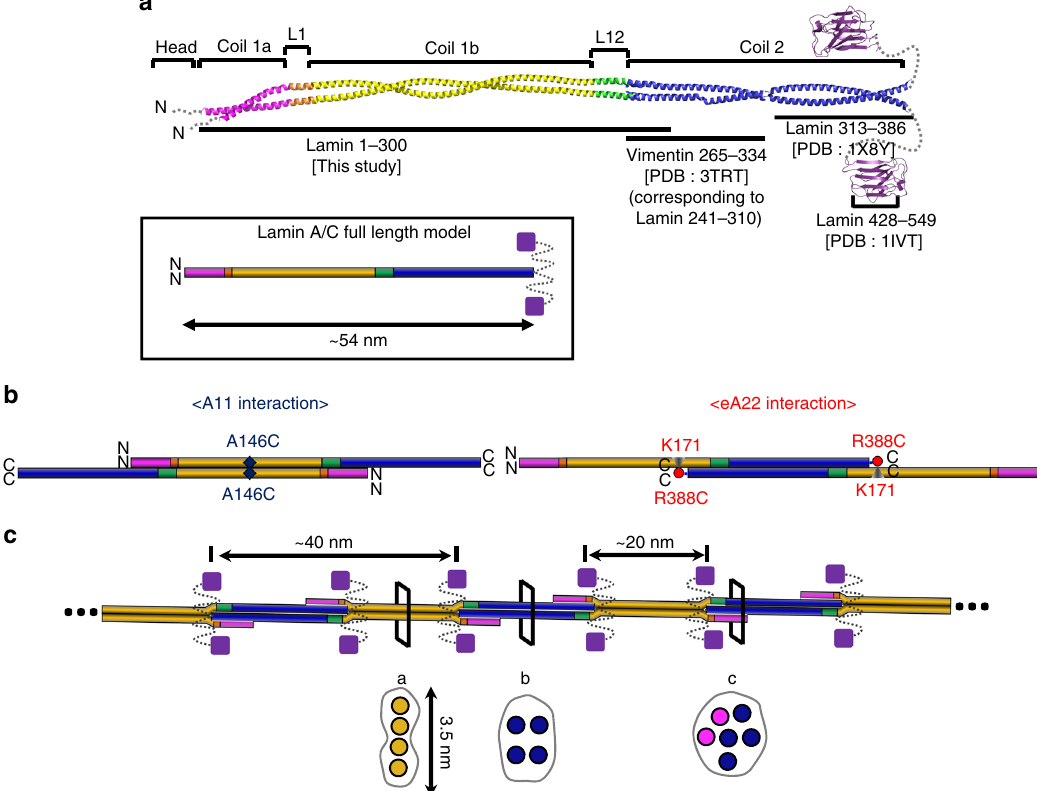
Fig. 7 Proposed assembly mechanism of lamin by the A11 and eA22 interactions. a Coiled-coil dimer model of full-length lamin based on the lamin 300 fragment structure. The C-terminal region of coil 2 (residues 313 – 386; PDB code: 1 × 8Y 26 ) and the Ig-like domain (residues 428 – 549; PDB code: 1IVT 25 ) of human lamin A/C, were added to the structure described in this study. For the N-terminal region of coil 2, the corresponding vimentin fragment (PDB code 3TRT; 42 corresponding to residues 241 – 310 in lamin A/C) was used. The missing part (residues 283 – 385) in the central rod domain was built with the typical coiled-coil structure with a rise per residue of 1.5 Å. The unstructured regions (N-terminal head, NLS, and C-terminal tail) are indicated by dotted lines. Schematic drawings of the dimer model of the 54-nm-long full-length lamin A/C is in the box. b Two different tetrameric assemblies by the A11 or eA22 interactions. Each band in the same colour code as in Fig. 1a represents the coiled-coil dimer. Left, the A11 interaction-based tetrameric assembly. Right, the eA22 interaction-based tetrameric assembly. The nearby residues mapped by the disul fi de or the chemical cross-linking assays are labelled. c The model of the mature lamin fi lament, formed by the successive and alternative A11 and eA22 interactions between the dimers. When a pair of Ig-like domains (violet square) are placed on the both sides of the tetramers, the distance between the neighbouring Ig-like domains is ~20 nm. Schematic cross- sections (a – c) of the lamin fi lament model are shown in the bottom (circles represent intersection of an α -helix, binding motif are in brown). The cross- section a is equivalent to Fig. 6d, and b to Fig. 6e, while c is an arbitrary arrangement of 6 α